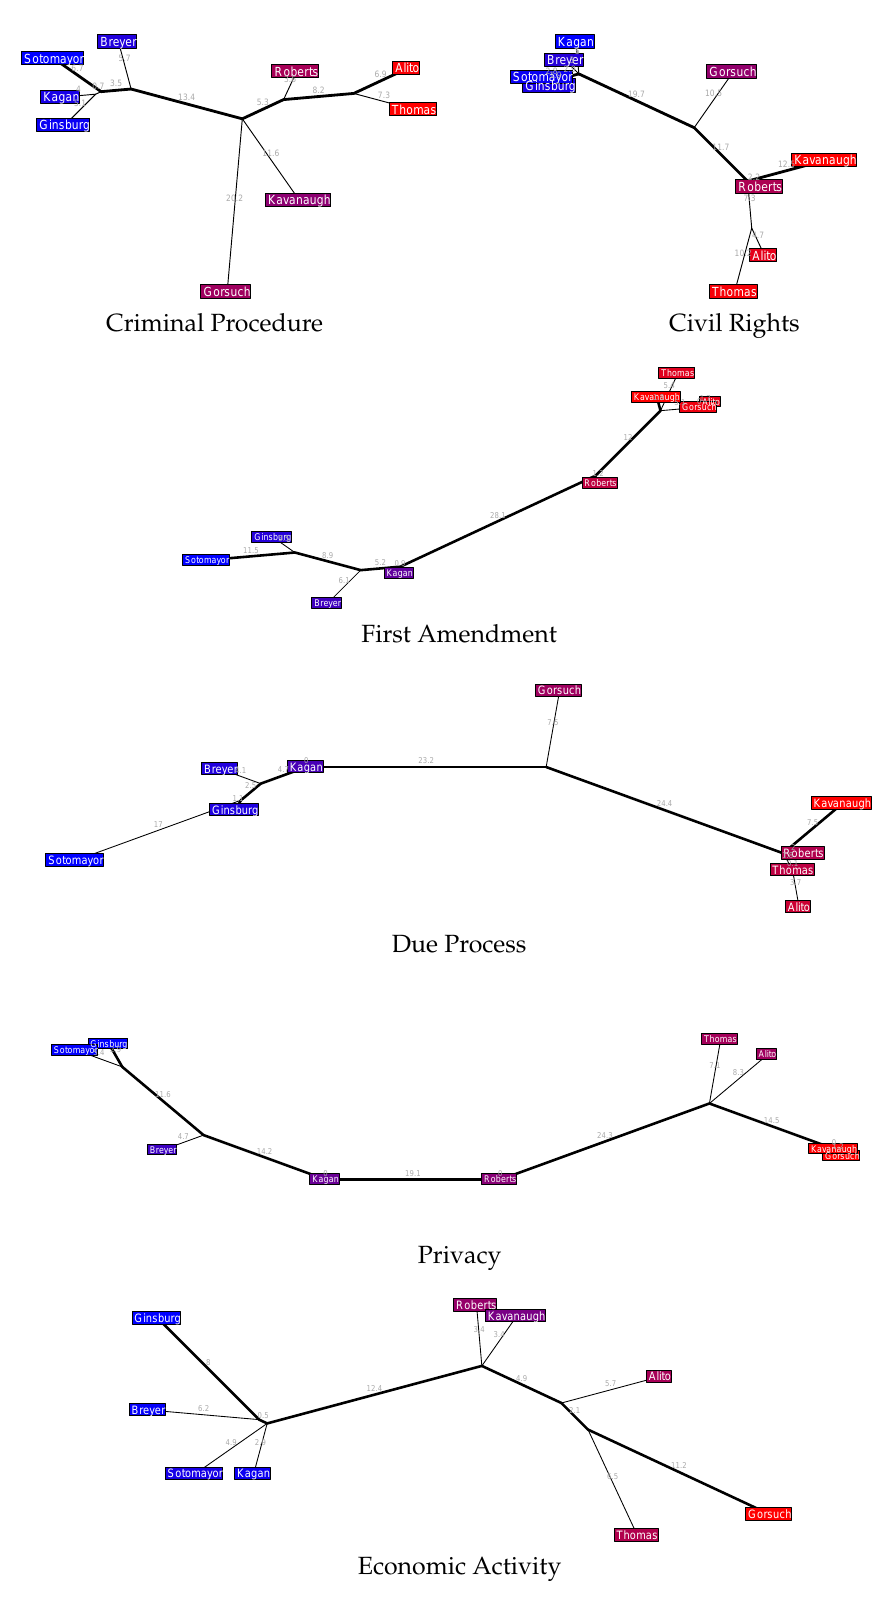
Figure 12. Judicial trees for the 2018–2020 Roberts 7 Court, separated by issue